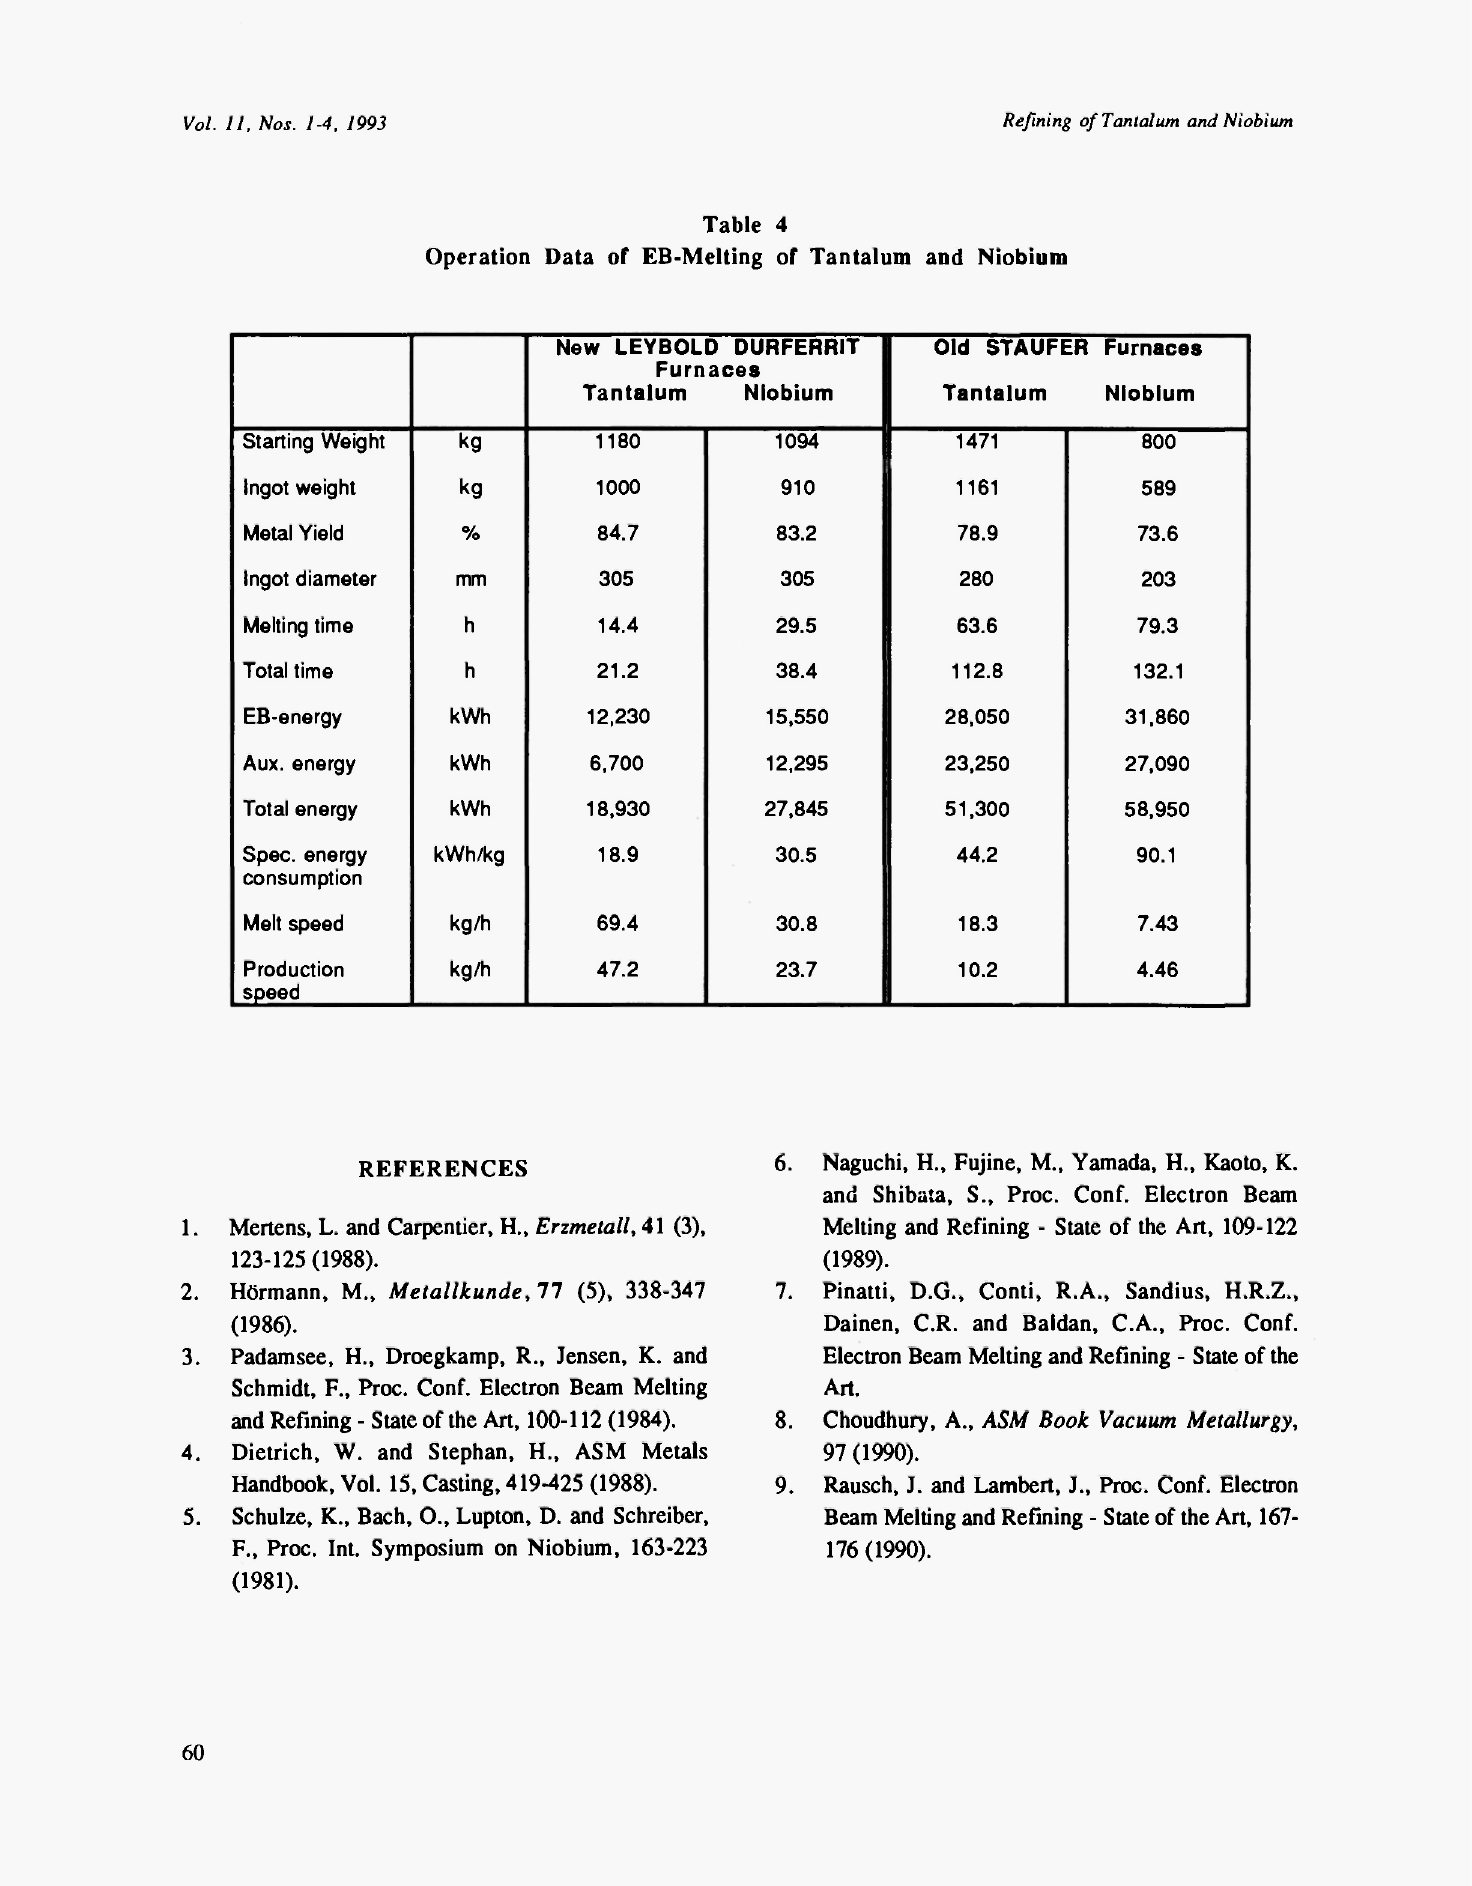
Operation Data of EB-Melting of Tantalum and